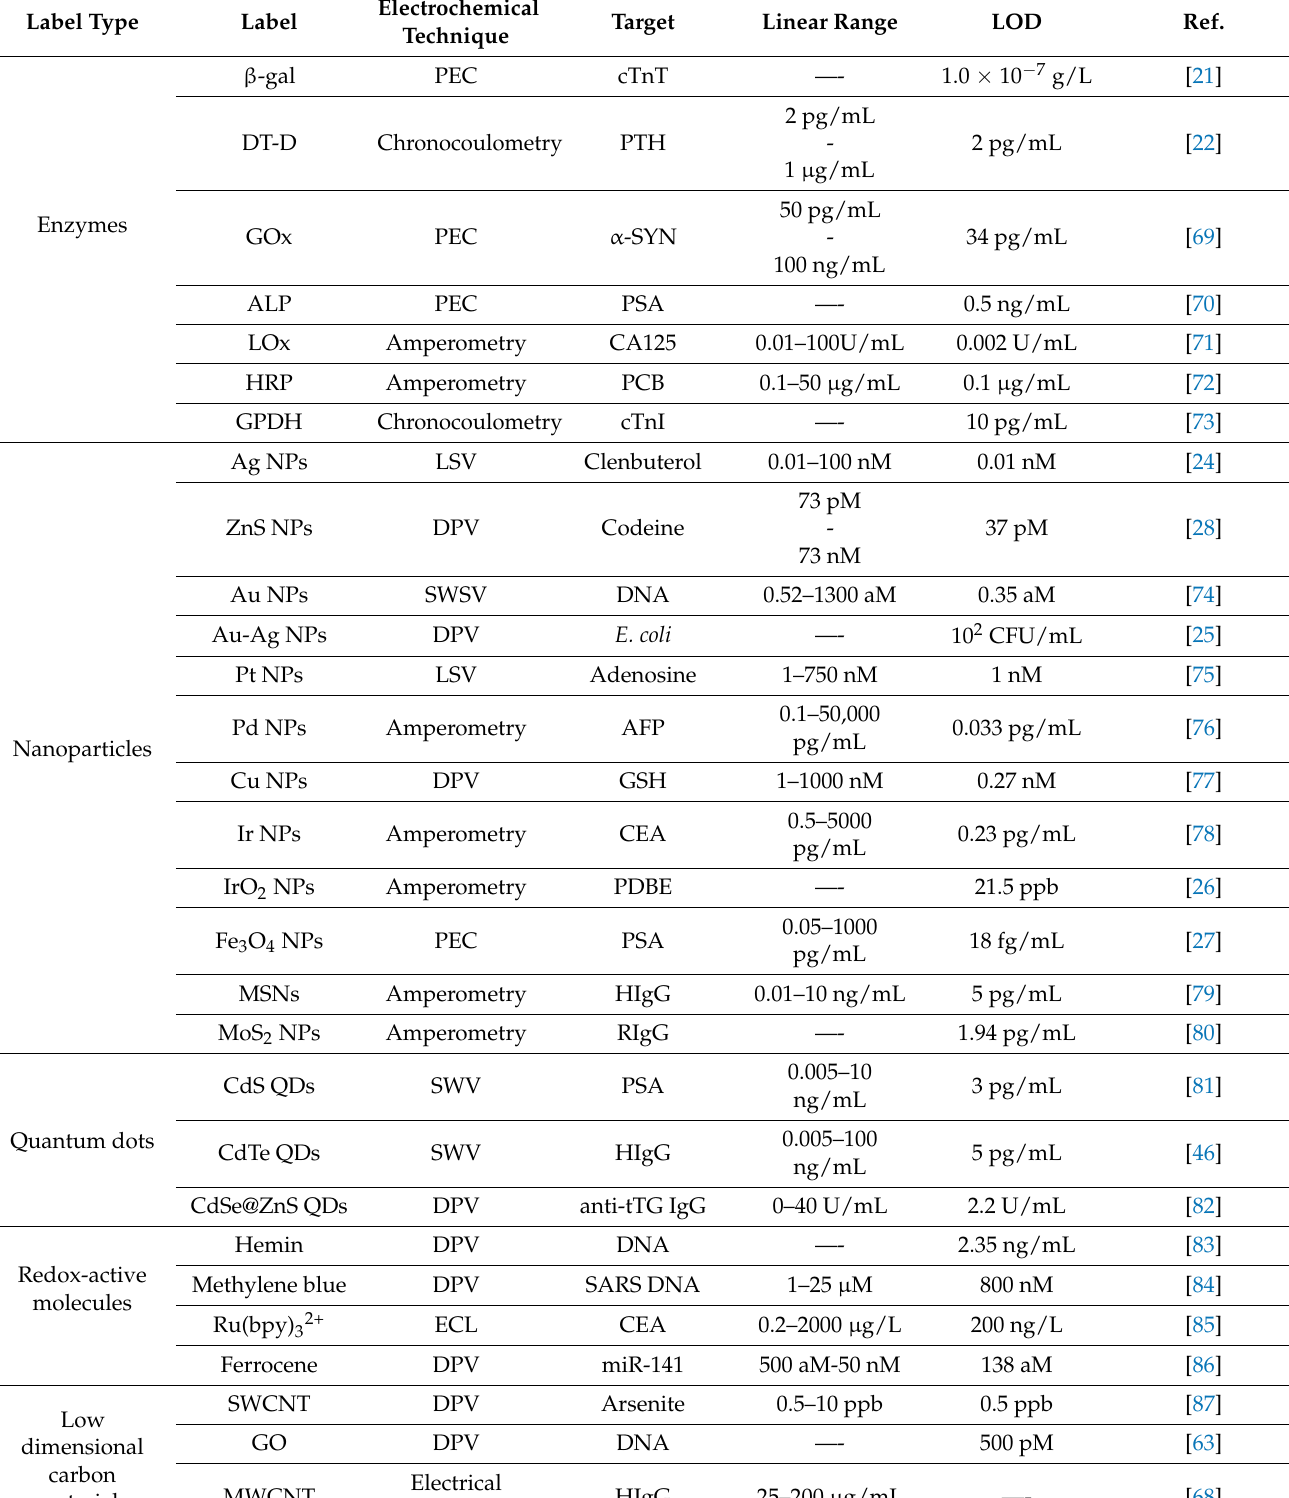
Table 1. Literature comparison of the analytical performance of various labels reported for electrochemical